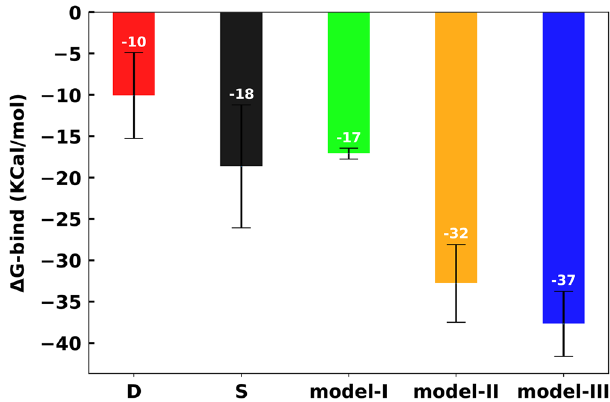
Figure 11. Relative binding free energy components for RBD-ACE2 complex. Overall binding free energy of models D, S, I–III are shown in red, black, lime, orange and